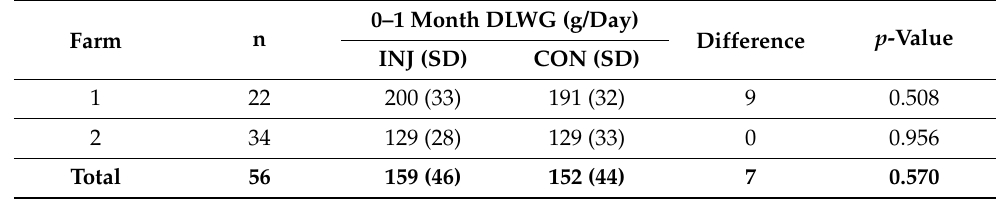
Table 7. Overall DLWG in kids between 0 and 1